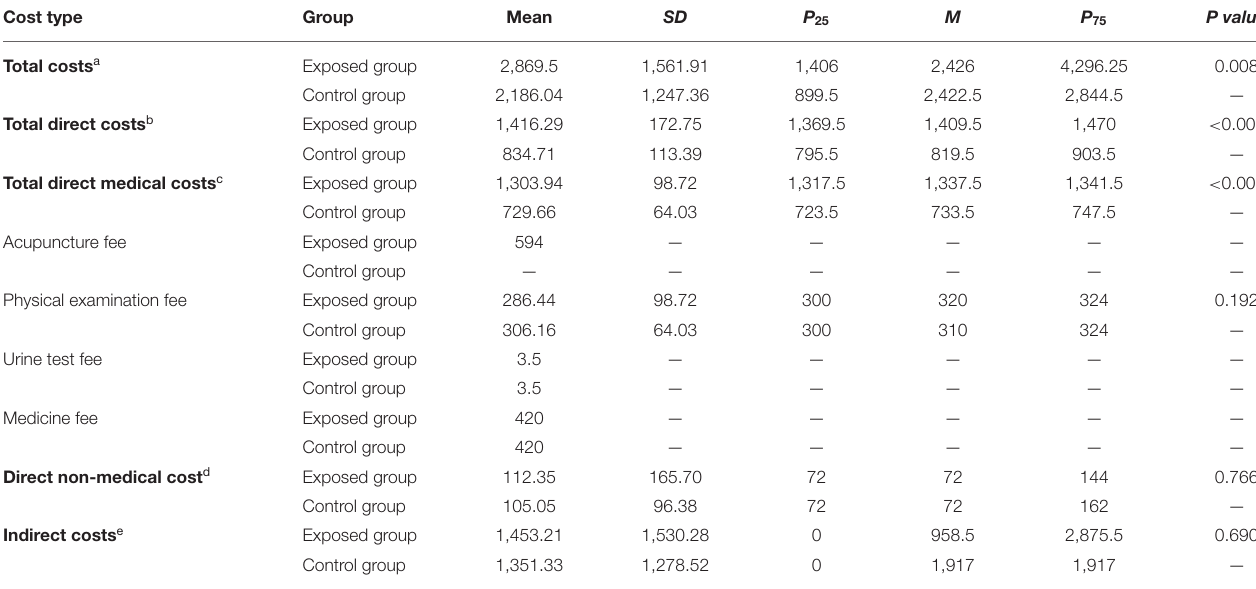
TABLE 4 | Description of different types of costs (Unit: CNY).